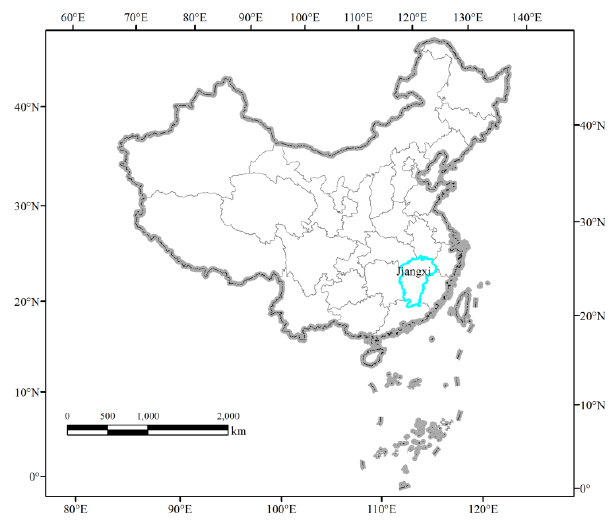
Figure 1. Location of the typical deforestation and afforestation